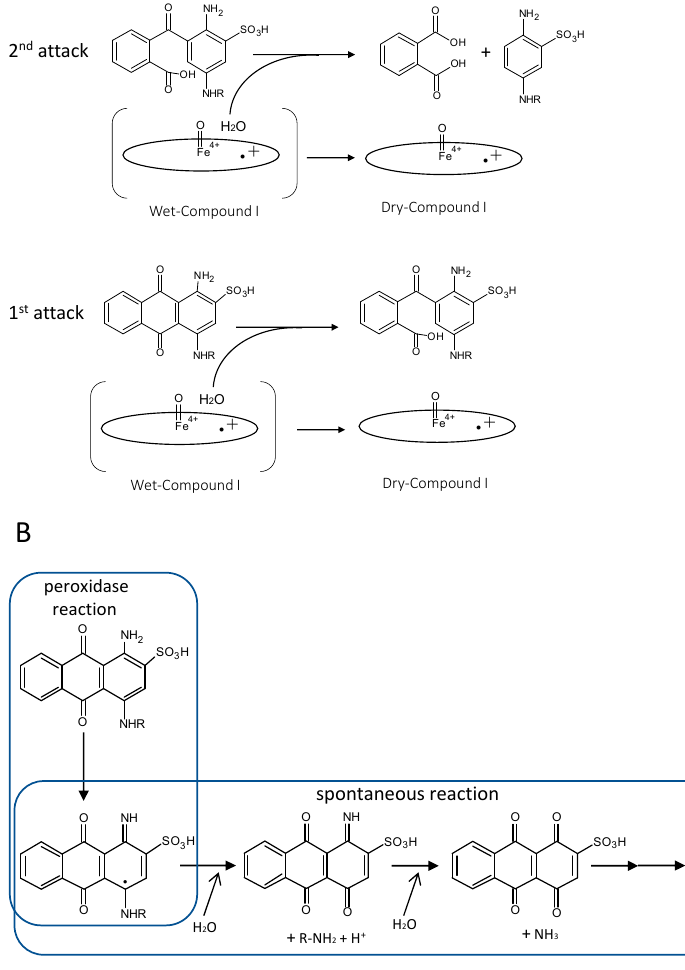
Figure 4. Comparison of proposed anthraquinone degradation mechanisms. A, H 2 O from Wet compound I attacks the anthraquinone frame, causing enzymatic hydrolysis [44]. Oval denotes the heme plane in the enzyme. B, Spontaneous hydrolysis generates phthalic acid, but predicted intermediates have not been detected [66].